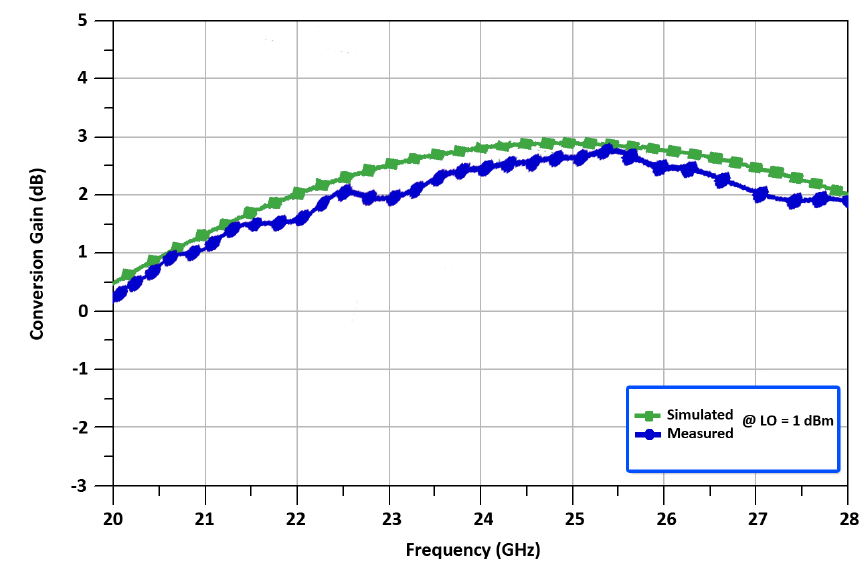
Figure 13. Conversion gain with respect to frequency of the mixer.